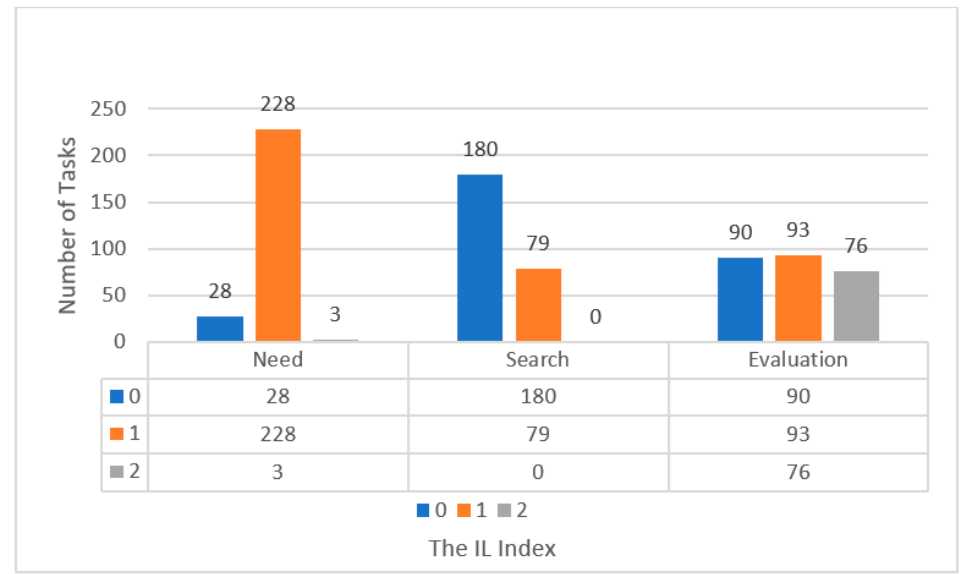
Figure 14. The ILH components. Note: While the total number of tasks reported in the studies equaled 262, the maximum number in this figure is 259. This is because the descriptions of three tasks in the published research did not provide enough information for coding.